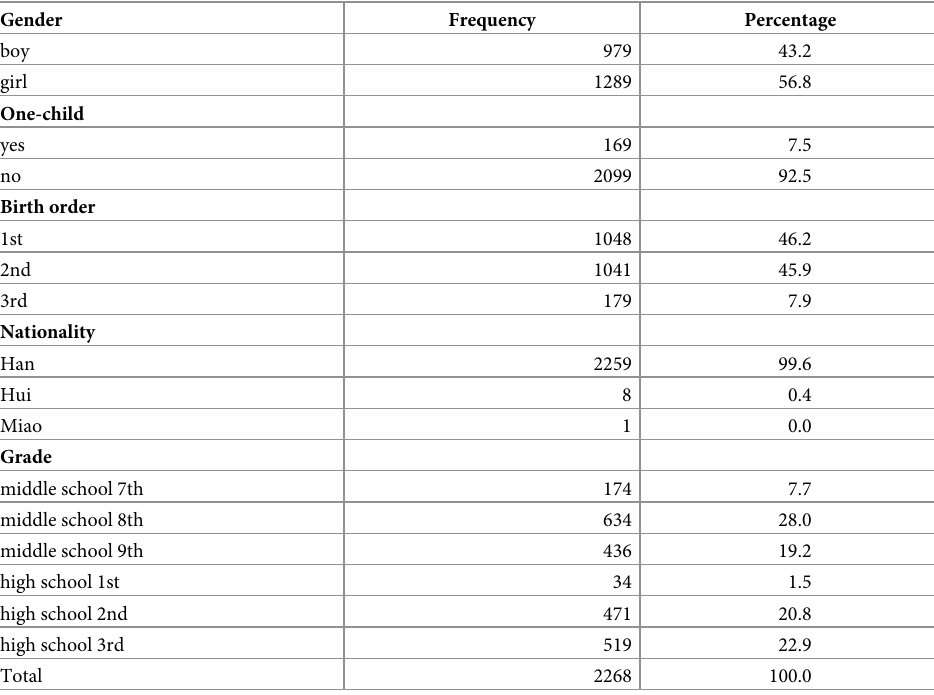
Table 1. Demographic profiles and descriptive statistics of the